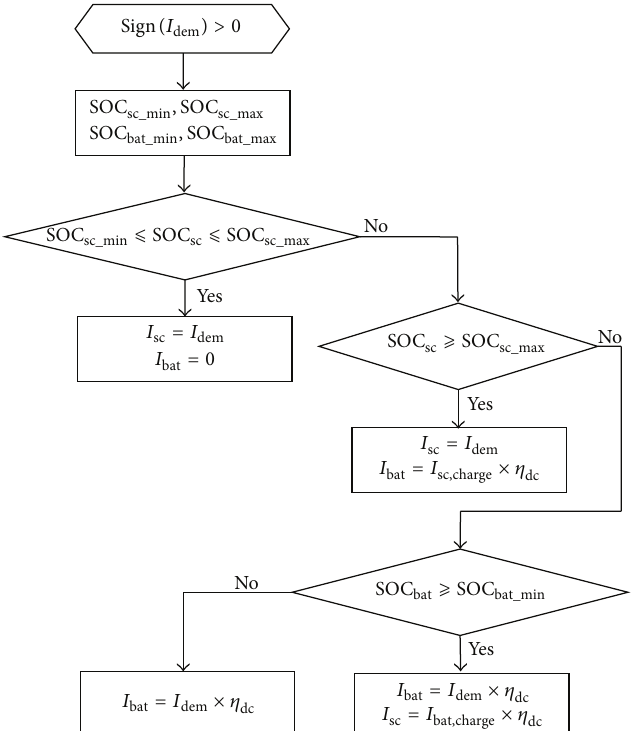
Figure 8: Flowchart of driving condition control